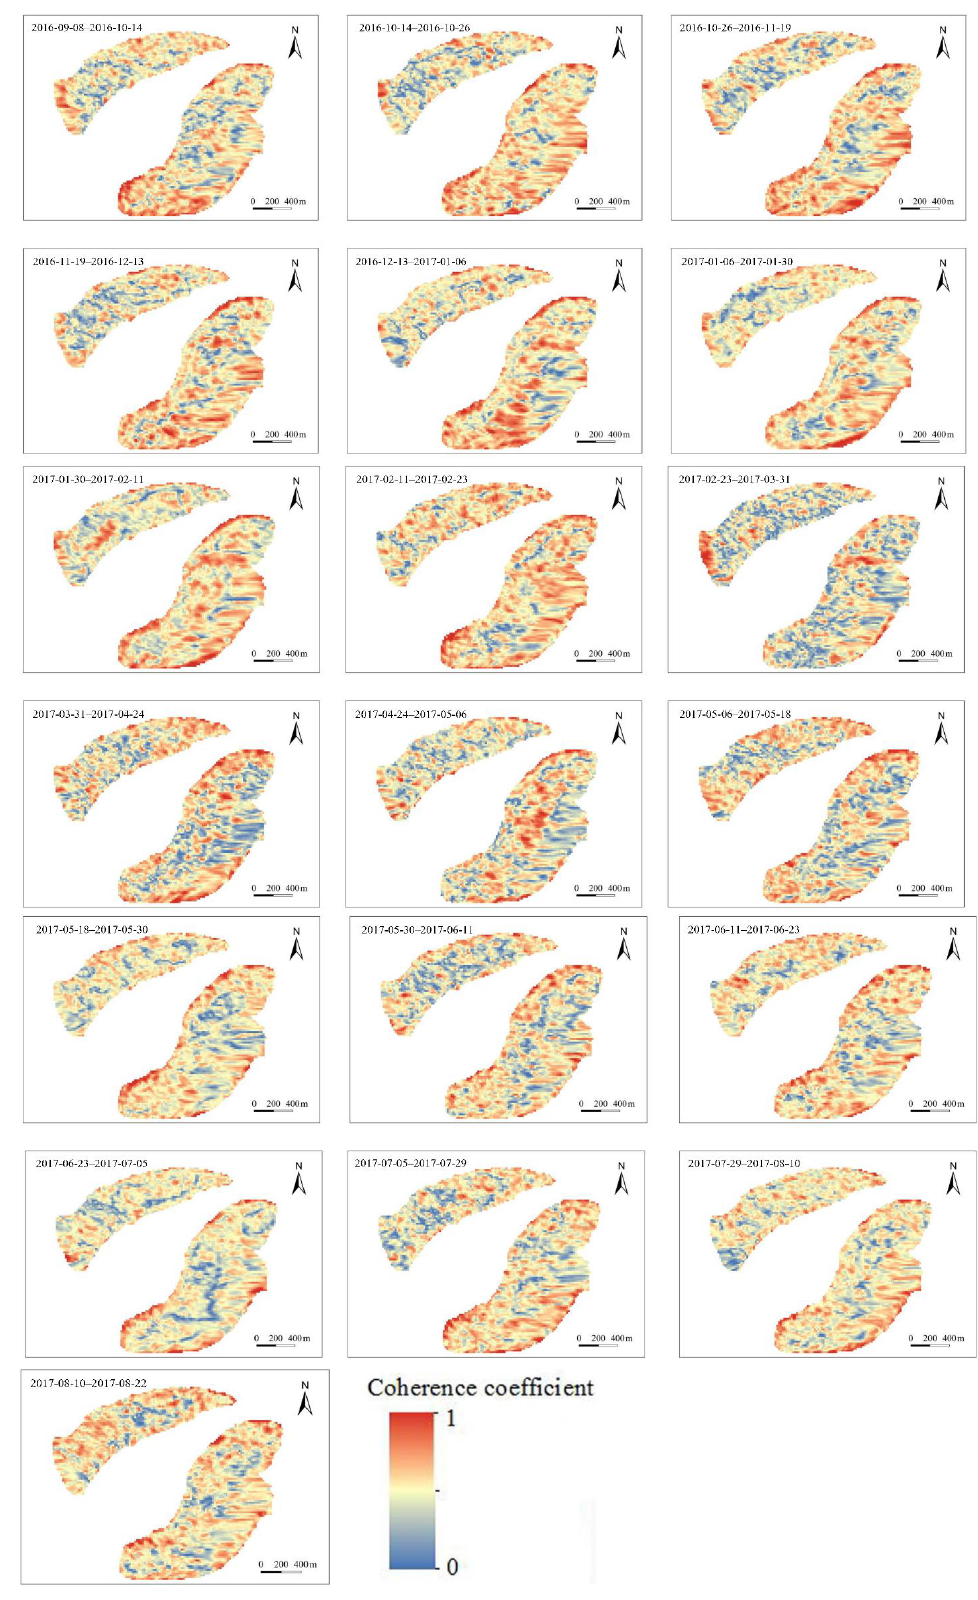
Figure A1. Coherence diagram of each ascending image pair.